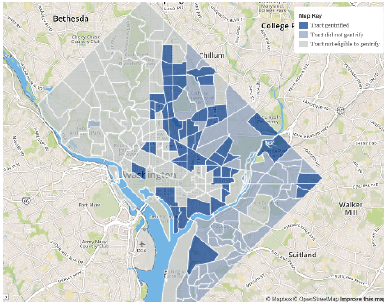
Figure 3. ( a ) Population distribution in Washington, DC by race. Each dot represents 25 people. Source: [28]; ( b ) Median household income. Source: [29]; ( c ) Gentrification trends: 2000–2013 using census (2000) and American Community Survey data (2009-2013) Source: [30].